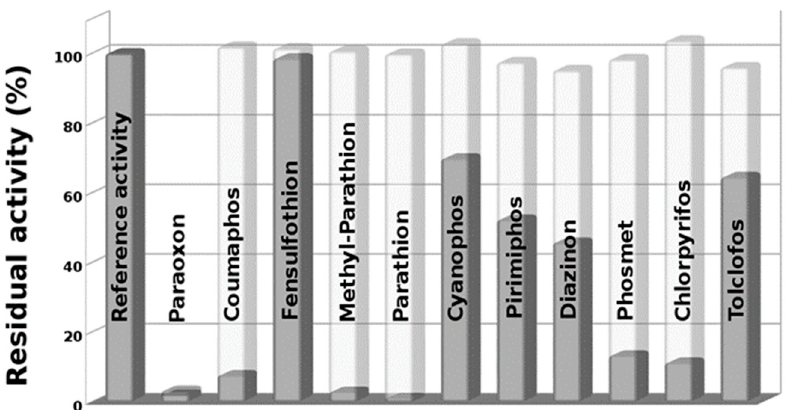
Figure 3. Plot of EST2 residual activity in absence (reference activity) and presence of different pesticides in their native form (light) and oxidized with NBS (dark).